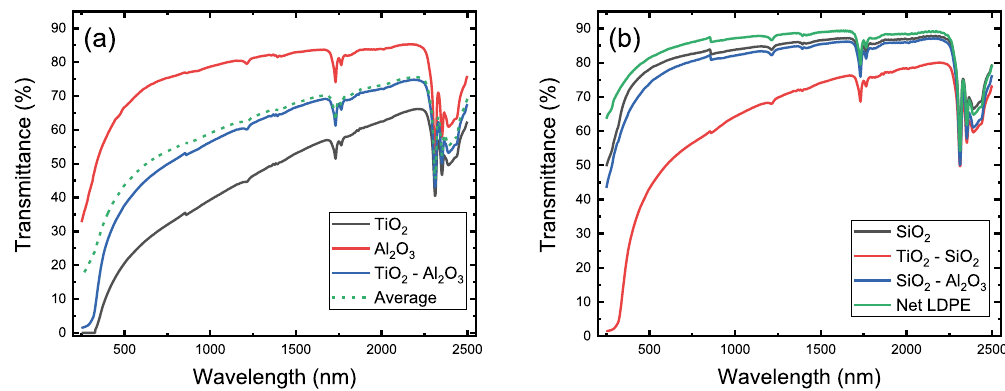
Figure 4. ( a ) Transmittance of TiO 2 , Al 2 O 3 and TiO 2 –Al 2 O 3 nanoparticles embedded in low density polyethylene (LDPE) from 250 to 2500 nm. The dashed line denotes the calculated average of the TiO 2 and Al 2 O 3 curves. ( b ) Transmittance of SiO 2 , TiO 2 –SiO 2 and SiO 2 –Al 2 O 3 nanoparticles embedded in LDPE. The curve of net LDPE is given for